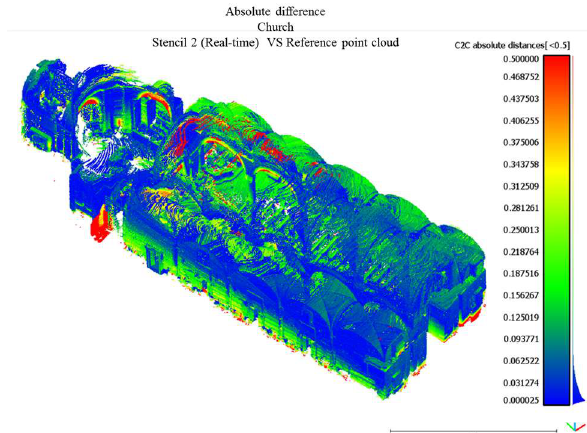
Figure 9. Comparison of point clouds between the real-time solution of the Stencil 2 and the reference model.